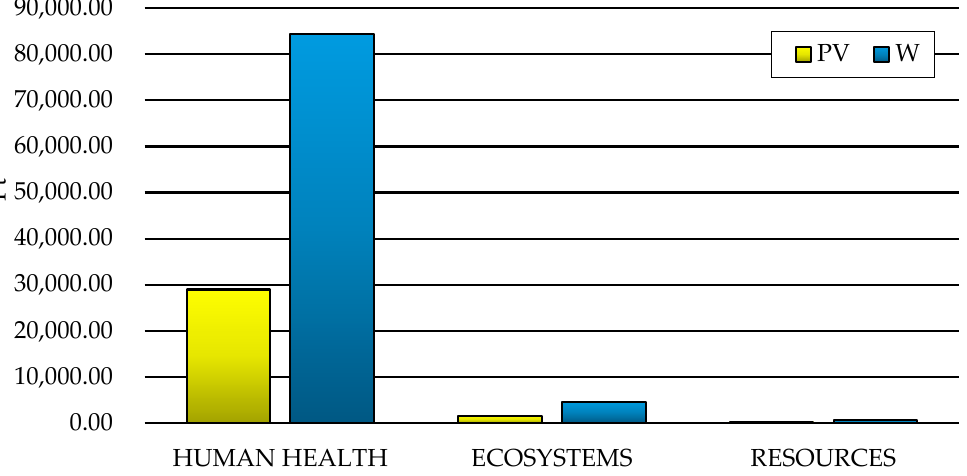
Figure 6. Grouping and weighting results of environmental effects for areas of influence present in the life cycle of wind (W) and photovoltaic (PV) power plants (unit: Pt).